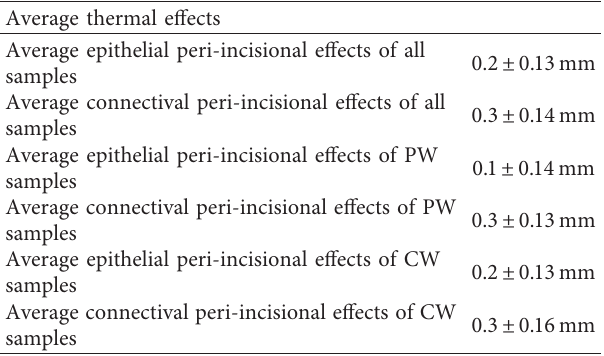
Figure 1: A line chart showing the average values in μ m obtained in the epithelium and connective tissue. Table 2: The mean peri-incisional effects.